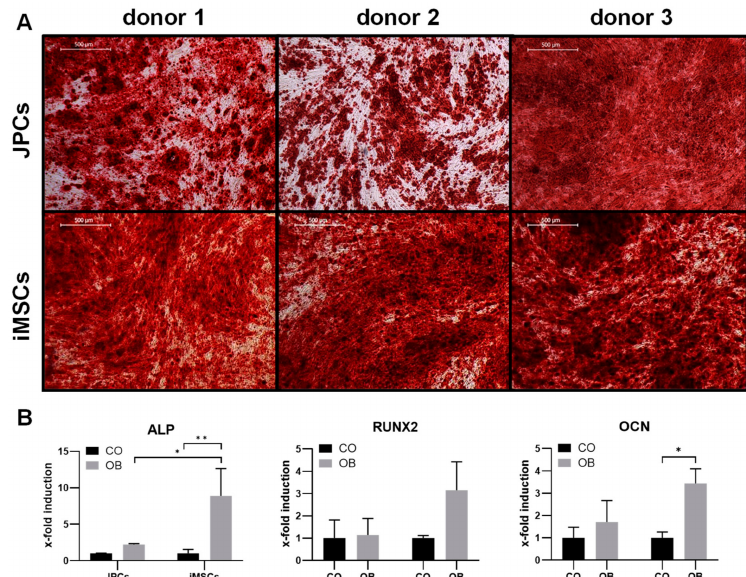
Figure 3. Osteogenic di ff erentiation of iMSCs and JPCs. ( A ) Alizarin red staining of JPCs (upper panel) and iMSCs (lower panel) treated with osteogenic medium (donor 2 and 3 JPCs and iMSCs for 15 days, donor 1 JPCs 25 days, donor 1 iMSCs 20 days) (4 × magnification, scale bar = 500 µ m). ( B ) Gene expression analysis ( ALP , RUNX2 , OCN ) of JPCs and iMSCs after 15 days of incubation in control (CO) and osteogenic medium (OB). Gene expression data of JPC and iMSC samples were normalized to the corresponding expression of the housekeeping gene GAPDH . Gene expression mean values ± SD of CO and OB samples were displayed as x-fold induction values relative to the CO samples. Statistical significance was calculated using two-way ANOVA ( n = 3 donors, * p < 0.05, ** p < 0.01).